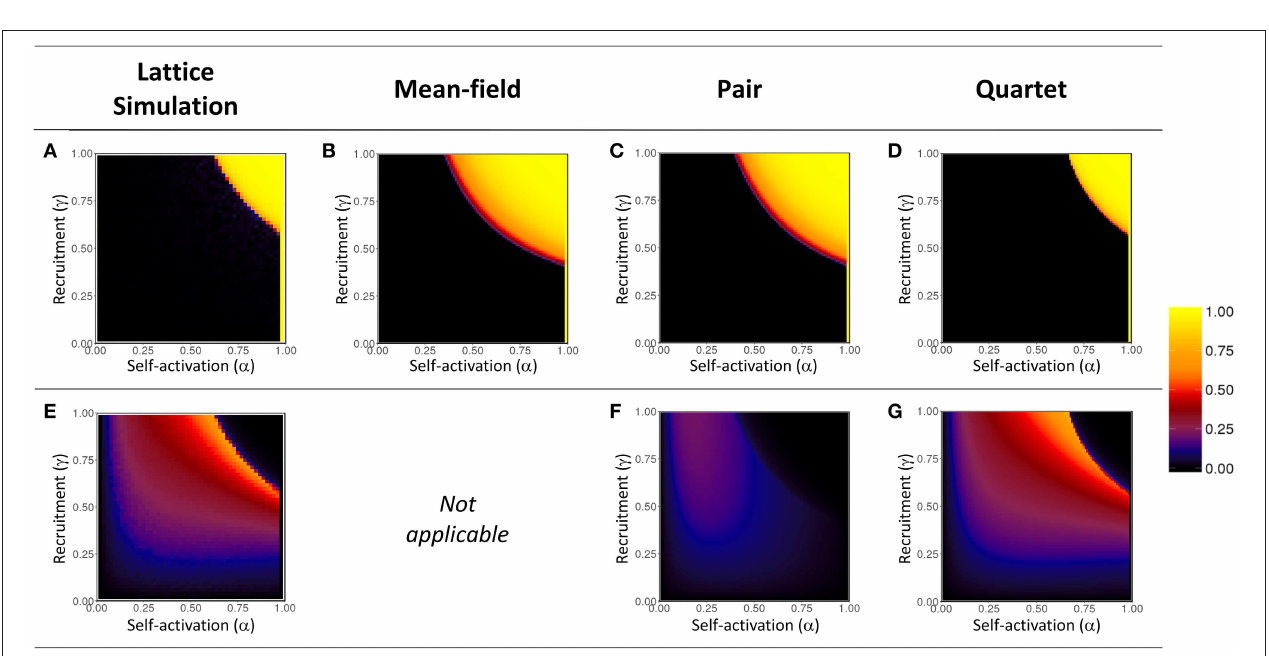
FIGURE 9 | Amplitude coefficient A (A) and clustering coefficient Q (B) as a function of recruitment probability γ , for self-activation probability α held at 0.80. Values measured at the end of 500,000 steps, for numerical simulations and for mean-field, pair, and quartet approximations. The clustering coefficient cannot be calculated with the mean-field approximation.